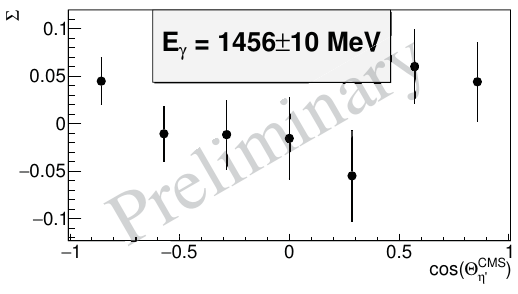
Figure 7. Beam asymmetry results. The errors are the errors of the cos(2 φ η (cid:2) )